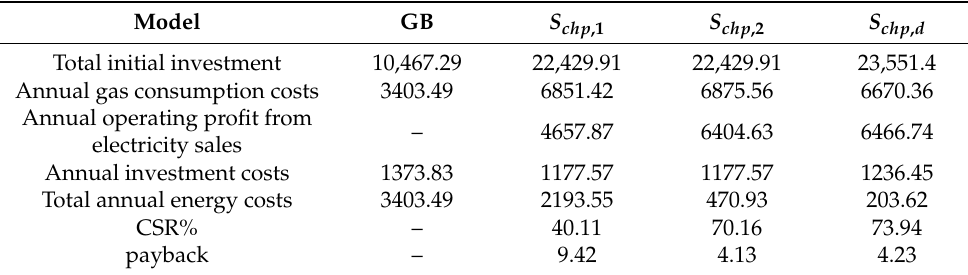
Table 5. The economic assessment index for three strategies and traditional